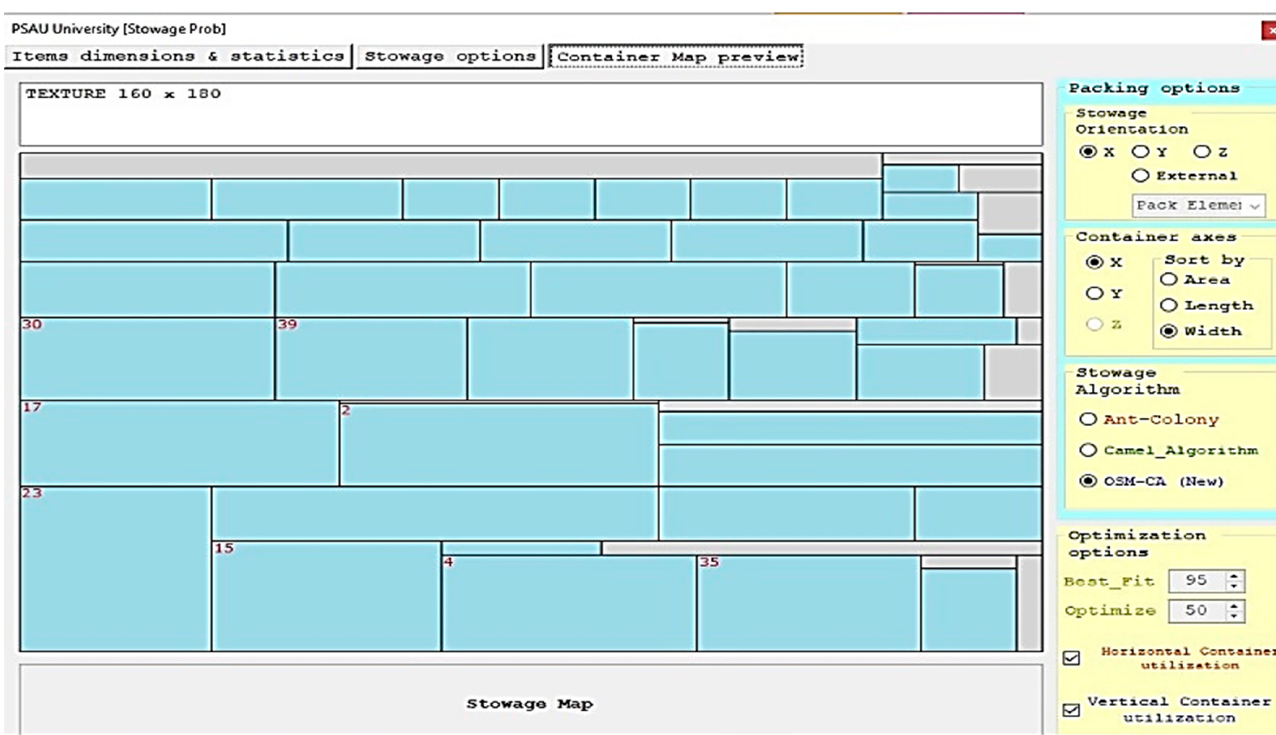
Figure A8. The container utilization by OSM-CA for third station on the distribution path.